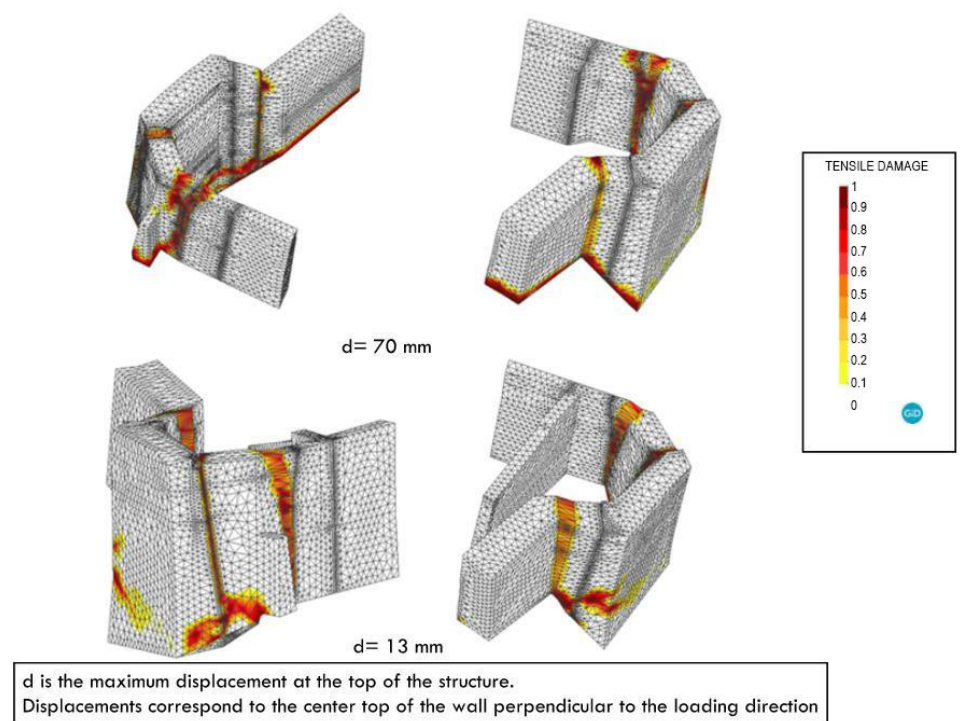
Figure 23. ( top ) Tensile damage in the pushover analysis carried out in the east – west direction (de- formation ×50); ( bottom ) tensile damage after imposed vertical movement (deformation ×50).